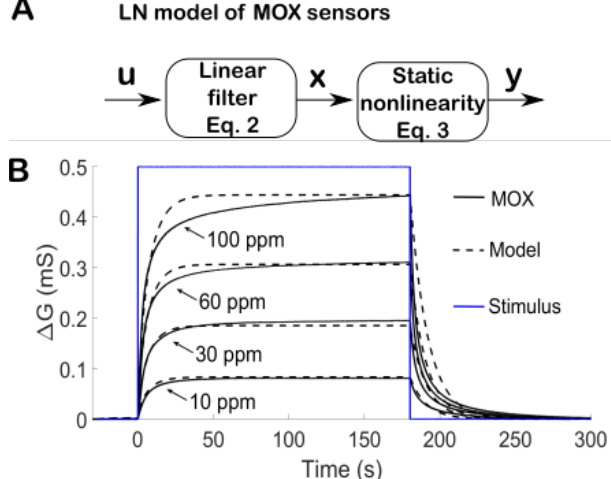
Figure 3. A The LN model of MOX sensors described by a cascade of a linear filter (Equation 2) and a static power-law nonlinearity (Equation 3). B Comparisons with experimental data . Simulation of the LN model (dashed black curve with 𝑎 = 0.9999, 𝛼 = 0.0157, 𝑟 = 0.7256) and comparison with real data (plain black curve) in response to a step-like stimulation of ethanol (blue curve) at different concentrations.